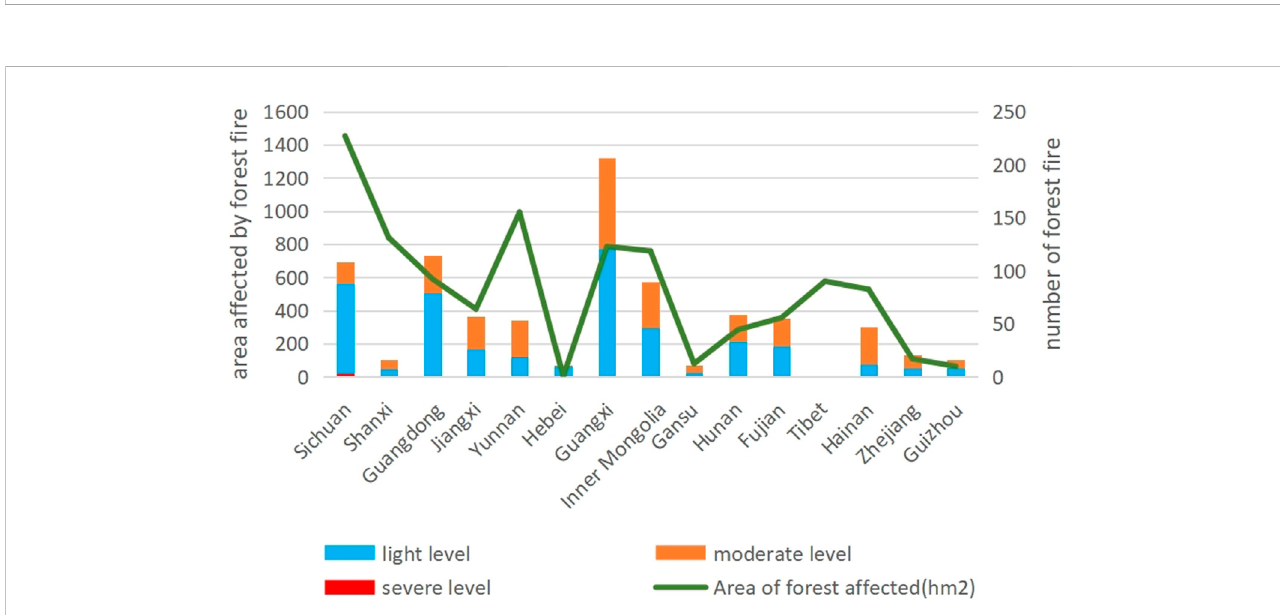
FIGURE 1 Discounted losses due to forest fi res in the sample provinces in 2020 (based on losses ordered from largest to smallest). Note: The primary axis is the damage discount (million yuan) and the secondary axis is the number of forest fi res.